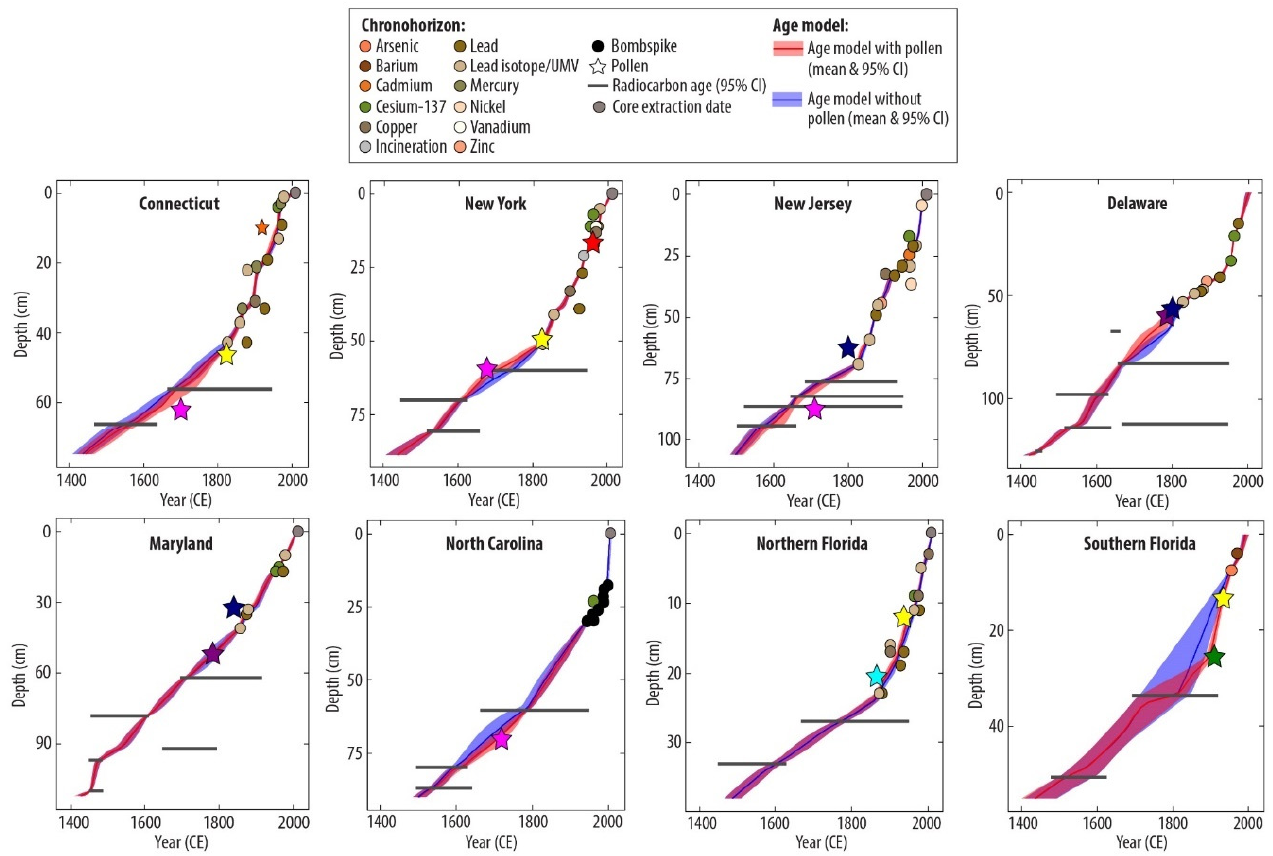
Figure 6. Median Bchron age–depth models for all study sites with 50% UIs showing the WP model in red and the NP model in blue. These were calculated based on the median of all 31 replicates. UMV refers to lead pollution originating in the Upper Mississippi Valley.